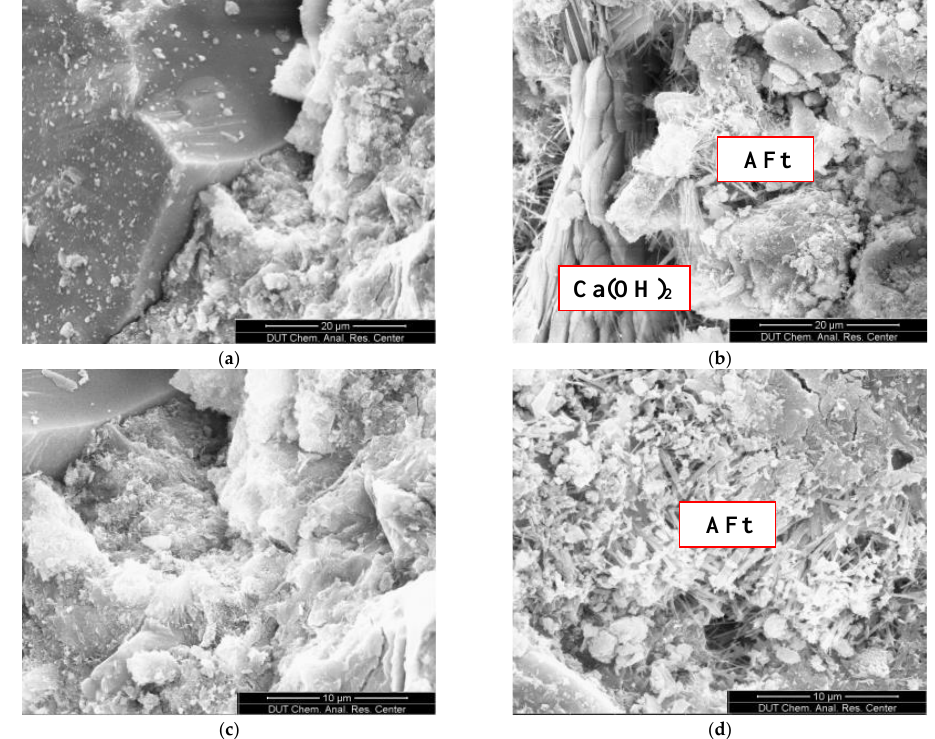
Figure 5. SEM images of concrete in different erosion environments: ( a ) fresh water, ( b ) sulfate, ( c ) chloride salt and ( d ) compound salt. 3.2. Influence of Strength Grade on Chloride ion Impermeability of Underwater Non-Dispersible Concrete Figure 6a – c show the chloride ion diffusion coefficients of concrete with different strength grades subjected to sulfate, chloride salt and composite salt erosion, respectively.